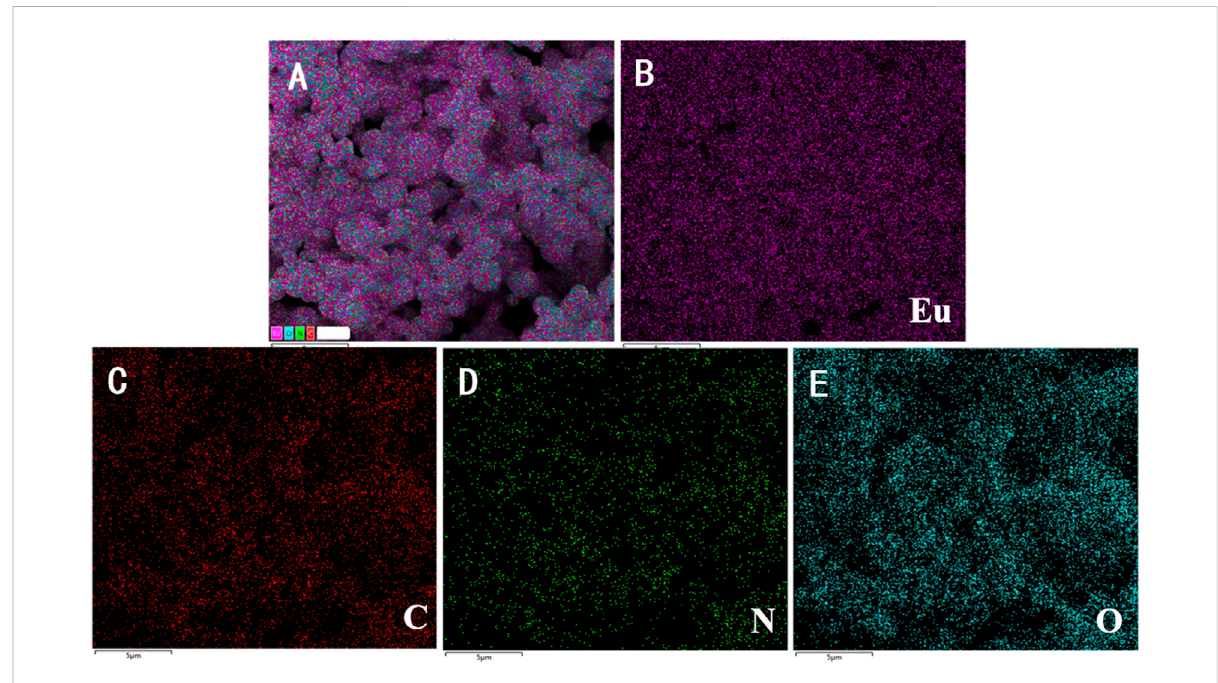
FIGURE 5 Elemental mapping images (EDS) of Eu-CP-Ara for (A) all the elements; (B) Eu; (C) C; (D) N; (E) O.